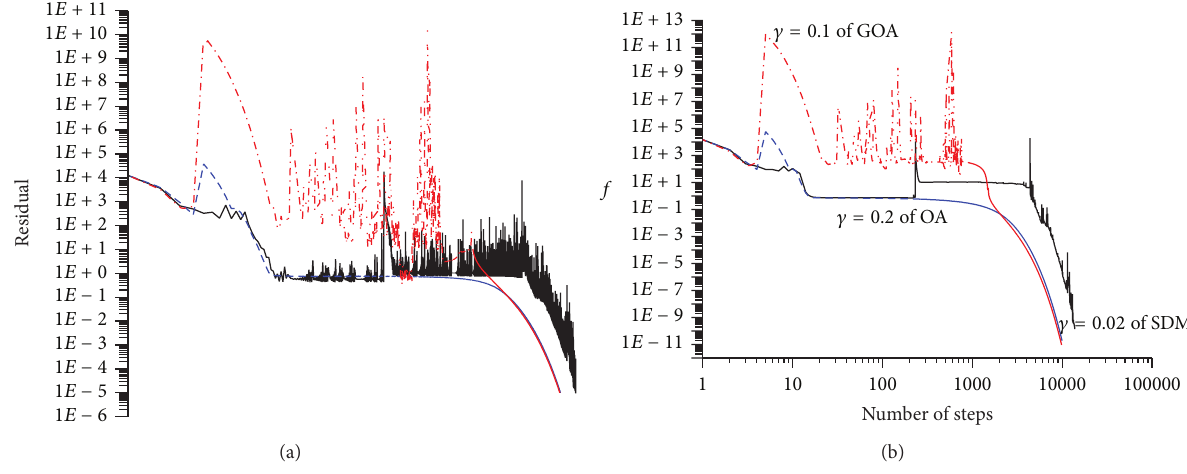
Figure 2: For the generalized Rosenbrock problem, (a) the residuals and (b) the objective functions obtained by SDM, OA, and GOA.